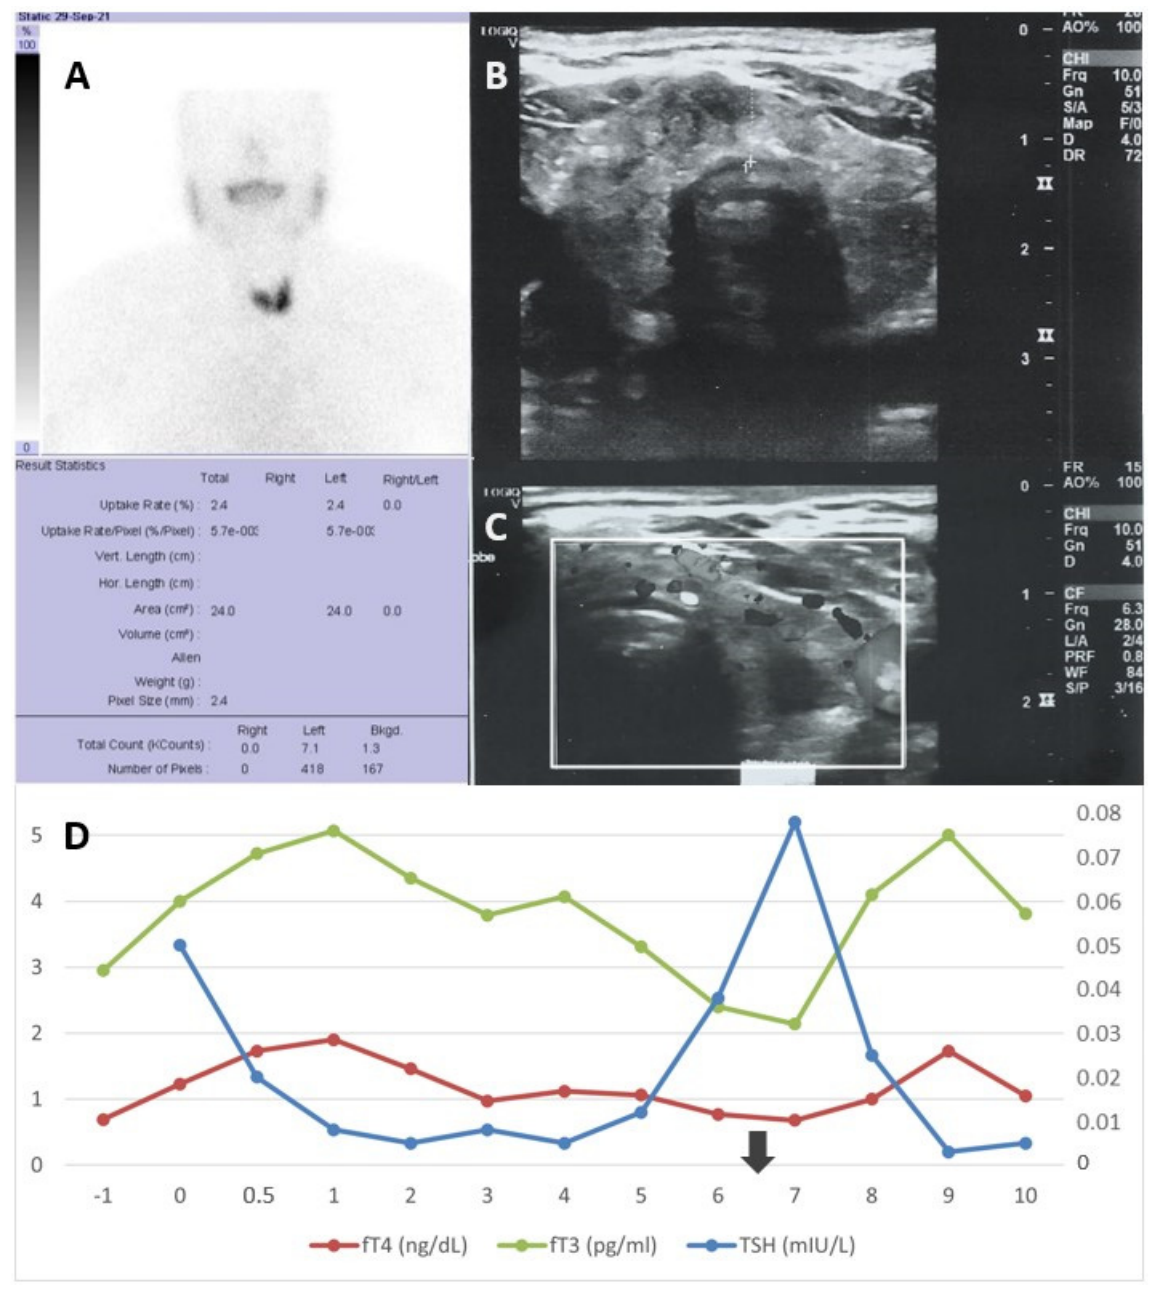
Figure 1. ( A ) Thyroid scintigraphy with Tc99 of case 1. The thyroid gland appears with diffuse increased activity, slightly more intense by the inferior left lobe. ( B ) Thyroid sonography of case 1. The gland appears heterogeneous, without nodules. ( C ) Thyroid Doppler sonography of case 1. Diffuse hypervascularity is observed (white frame). ( D ) Fluctuations of TSH in mIU/L, fT3 in pg/mL and fT4 in ng/dL of case 1 from baseline (three months before diagnosis) to date. Time since diagnosis is shown on x -axis in months. The fT3 and fT4 levels are plotted on the left y -axis and TSH levels are on the right one. The arrow represents time of infection.